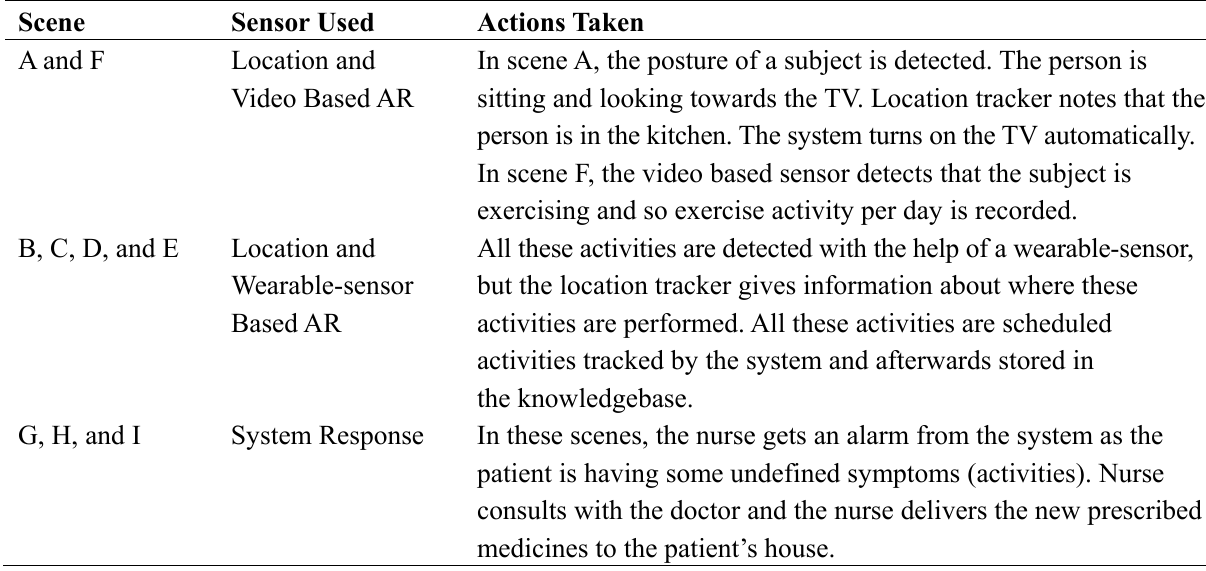
Table 2. Description of each scene with sensor(s) used and the consequent